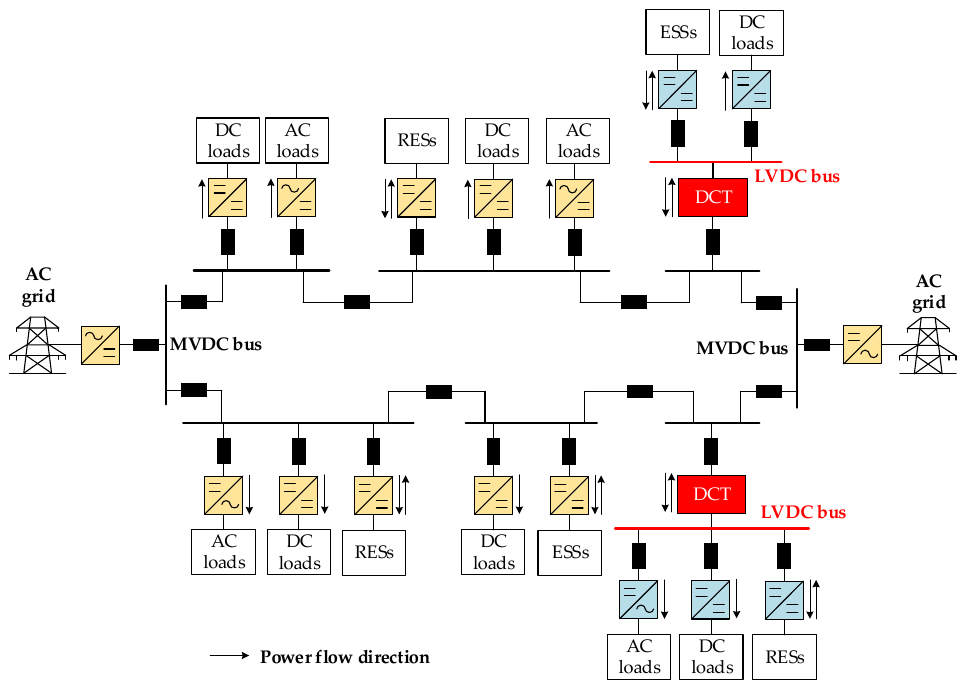
Figure 1. Structure of a M-LVDC distribution system.